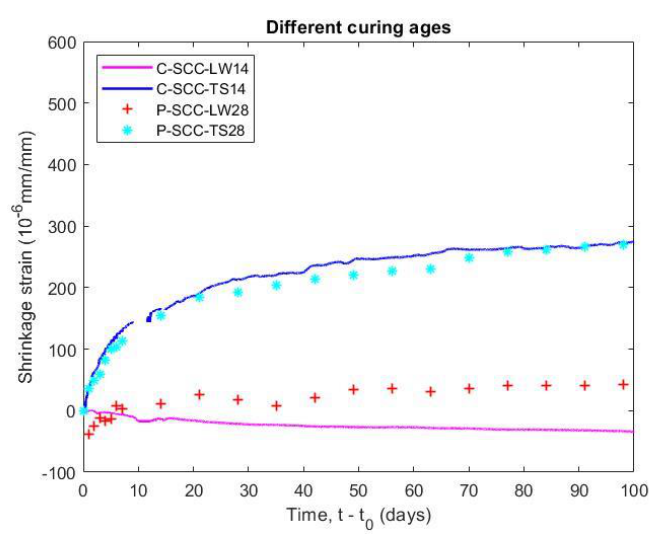
Figure 11. Effect of different curing ages on shrinkage of SCC specimens.